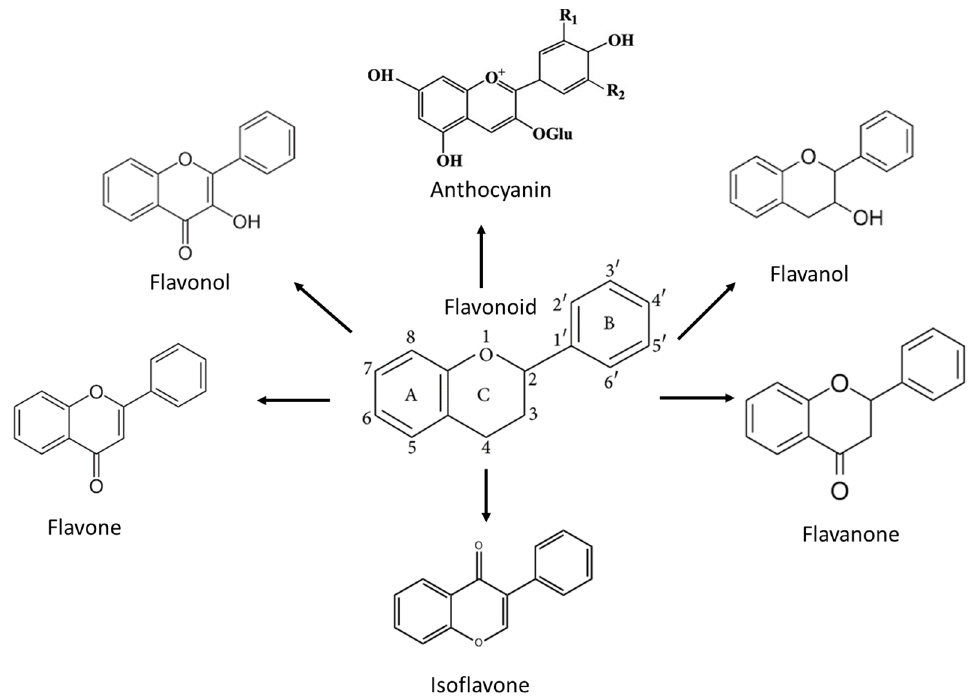
Figure 1. Basic chemical structure of flavonoids and their subclasses. Table 1. Chemical structure of flavonoid compounds and their respective common source.